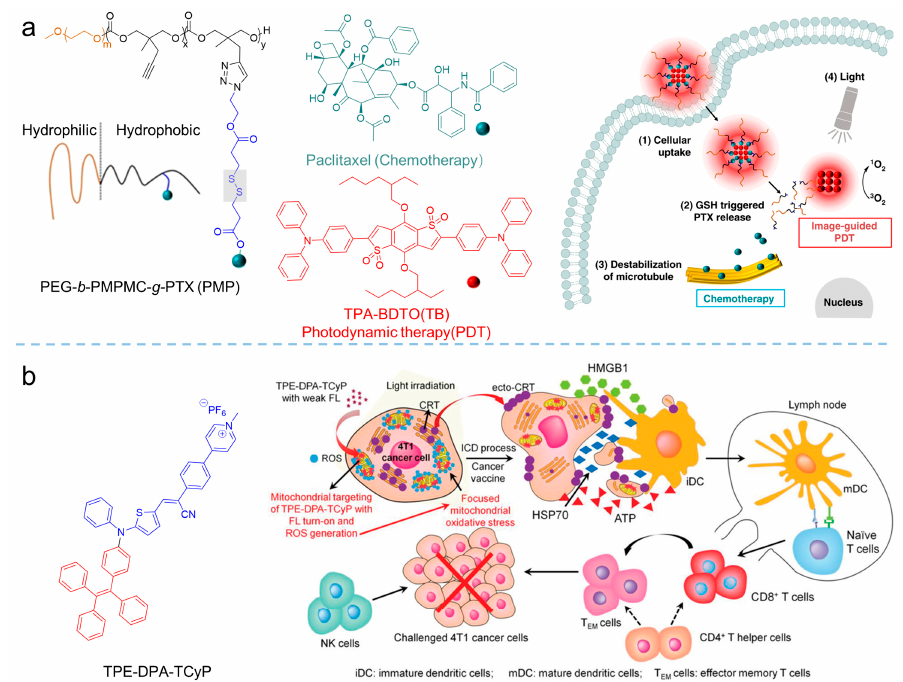
Figure 18. Synergistic therapy combining PDT. ( a ) Structure of the PEG- b -PMPMC- g -PTX (PMP) and TB@PMP (+), which was employed for combinational PDT/chemotherapy. Reprinted with the permission of the authors of [89]. Copyright 2018, by the author(s). Published by Springer Nature. ( b ) Schematic illustration of TPE-DPA-TCyP as an effective ICD inducer for antitumor immunity. Reprinted with the permission of the authors of [94]. Copyright 2019, Wiley-VCH GmbH.